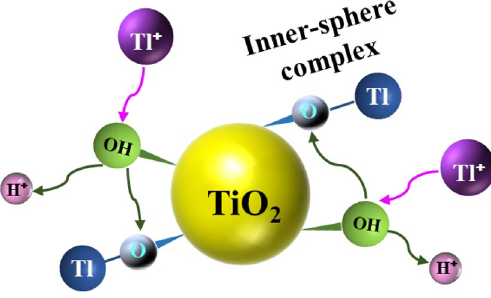
Figure 11. The proposed mechanism of Tl(I) adsorption on TiO 2